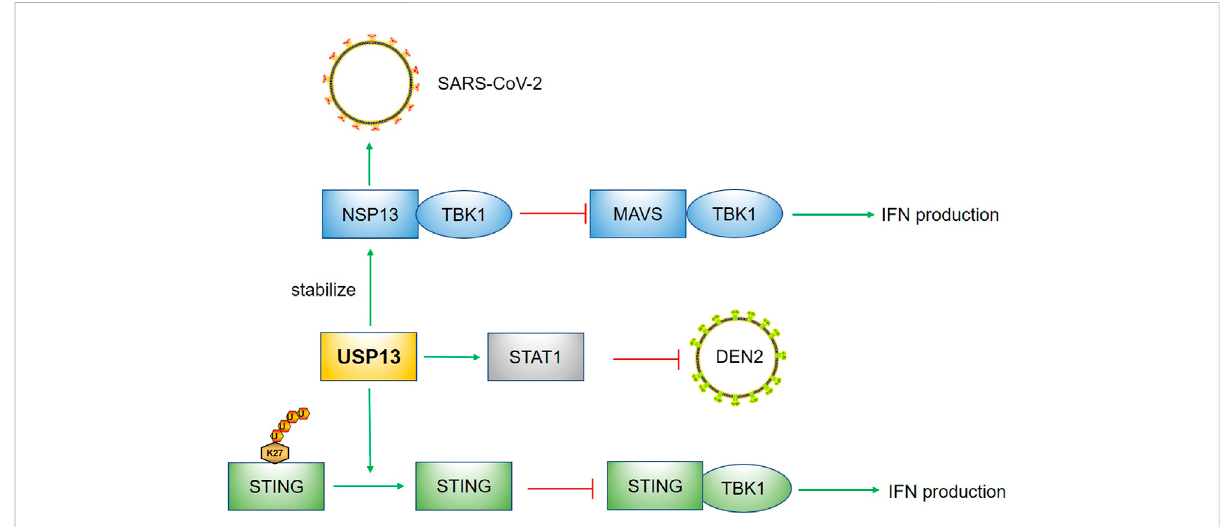
FIGURE 4 USP13 in infection. USP13 stabilized STAT1 to suppress DEN2. The removal of K27 linked polyubiquitin chain of STING by USP13 hindered the recruitment of TBK1 to STING, leading to reduction of IFN production. The NSP13 of SARS-COV-2 could hijack USP13 to stabilize itself and the binding of NSP13 with TBK1 prevented MAVS-TBK1 signaling pathway. Green arrow indicates promotion; Red capped line represents